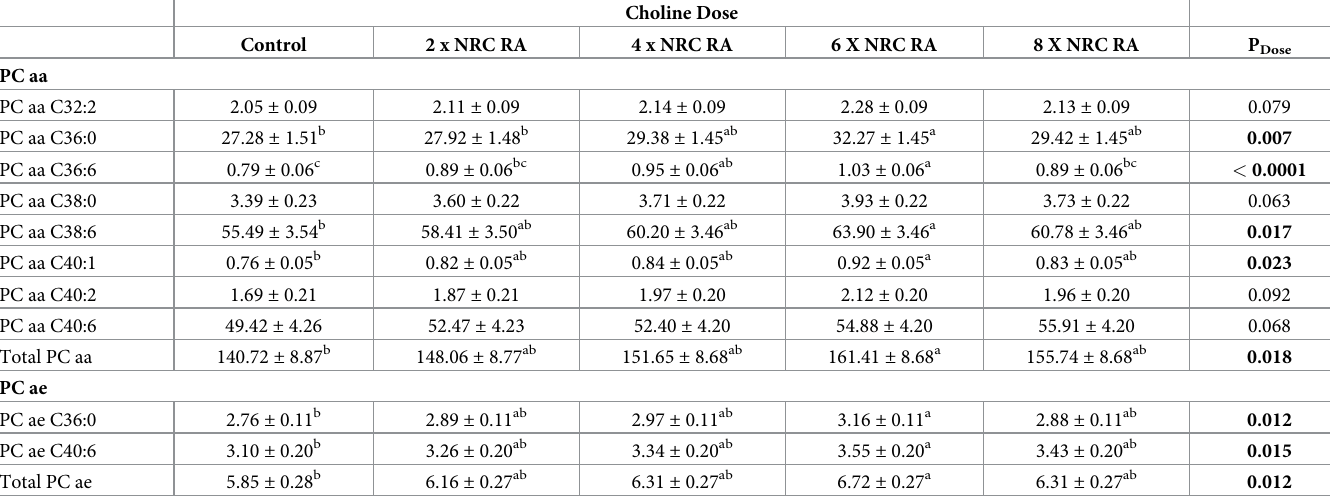
Table 5. Mean serum concentrations ( μ M) of PC aa and PC ae determined by DI-MS in overweight cats (n = 14) receiving control (no additional choline supplemen- tation, 1.2 x NRC RA, 77 mg/kg BW 0.67 ), choline at 2 x NRC RA (126 mg/kg BW 0.67 ), 4 x NRC RA (252 mg/kg BW 0.67 ), 6 x NRC RA (378 mg/kg BW 0.67 ), and 8